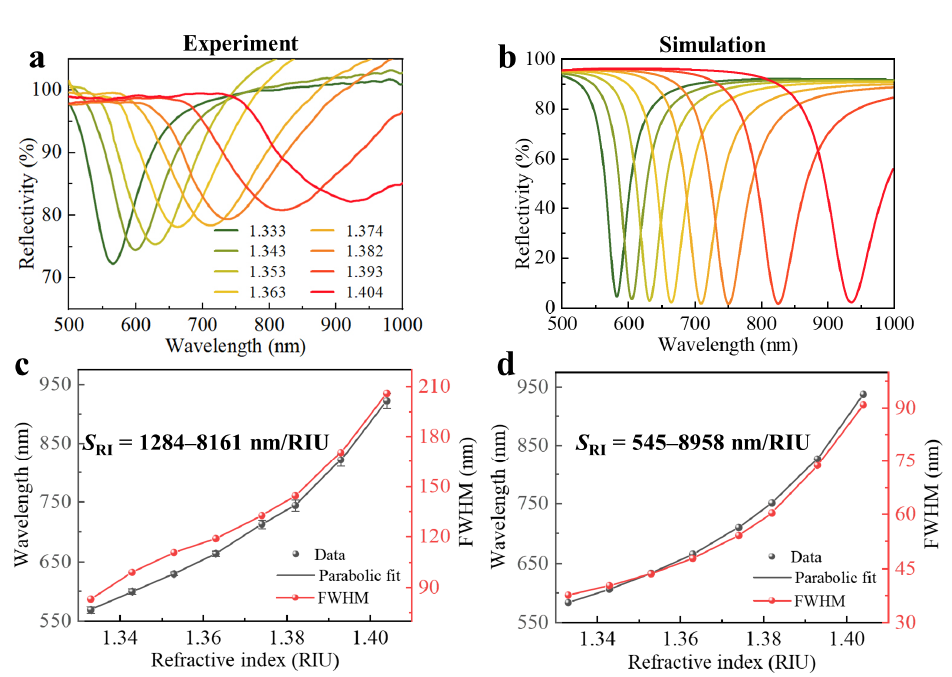
Figure 4. ( a ) Experimental and ( b ) simulated reflection spectra for different RIs. ( c , d ) Resonance wavelengths and spectral FWHM as a function of RIs, which correspond with panels ( a ) and ( b ), respectively.